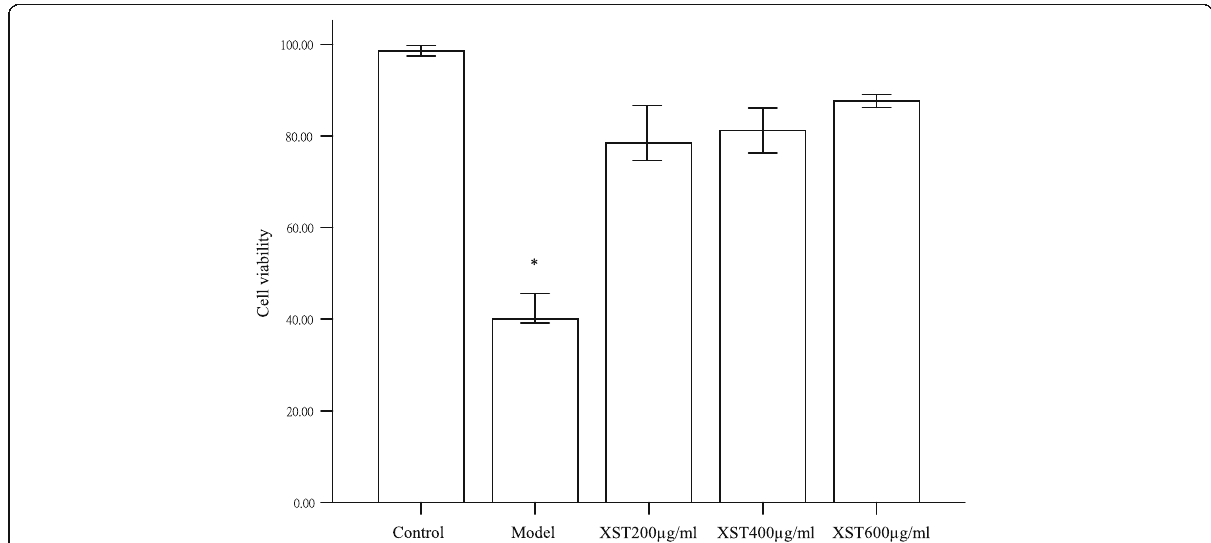
Fig. 1 Bar graphs showed the cell viability in the three XST-treated groups were significantly increased compared with the model group. No difference was found between the XST-treated groups or the XST-treated groups compared to the control group. All samples were checked in three independent experiments with three replicates each. Data are represented as the mean ± SD ( * P <0.05 vs. each of the three XST-treated groups or the control